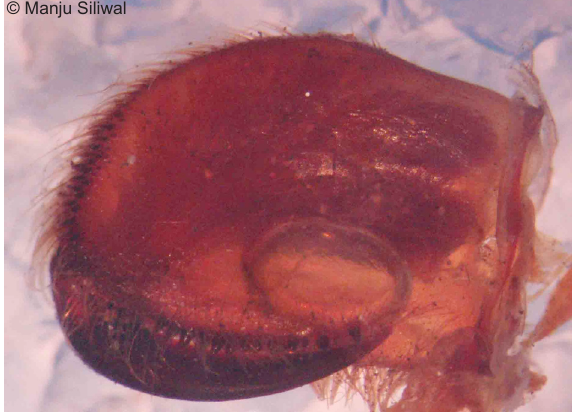
Image 6. Plesiophrictus bhori , chelicerae, prolateral view